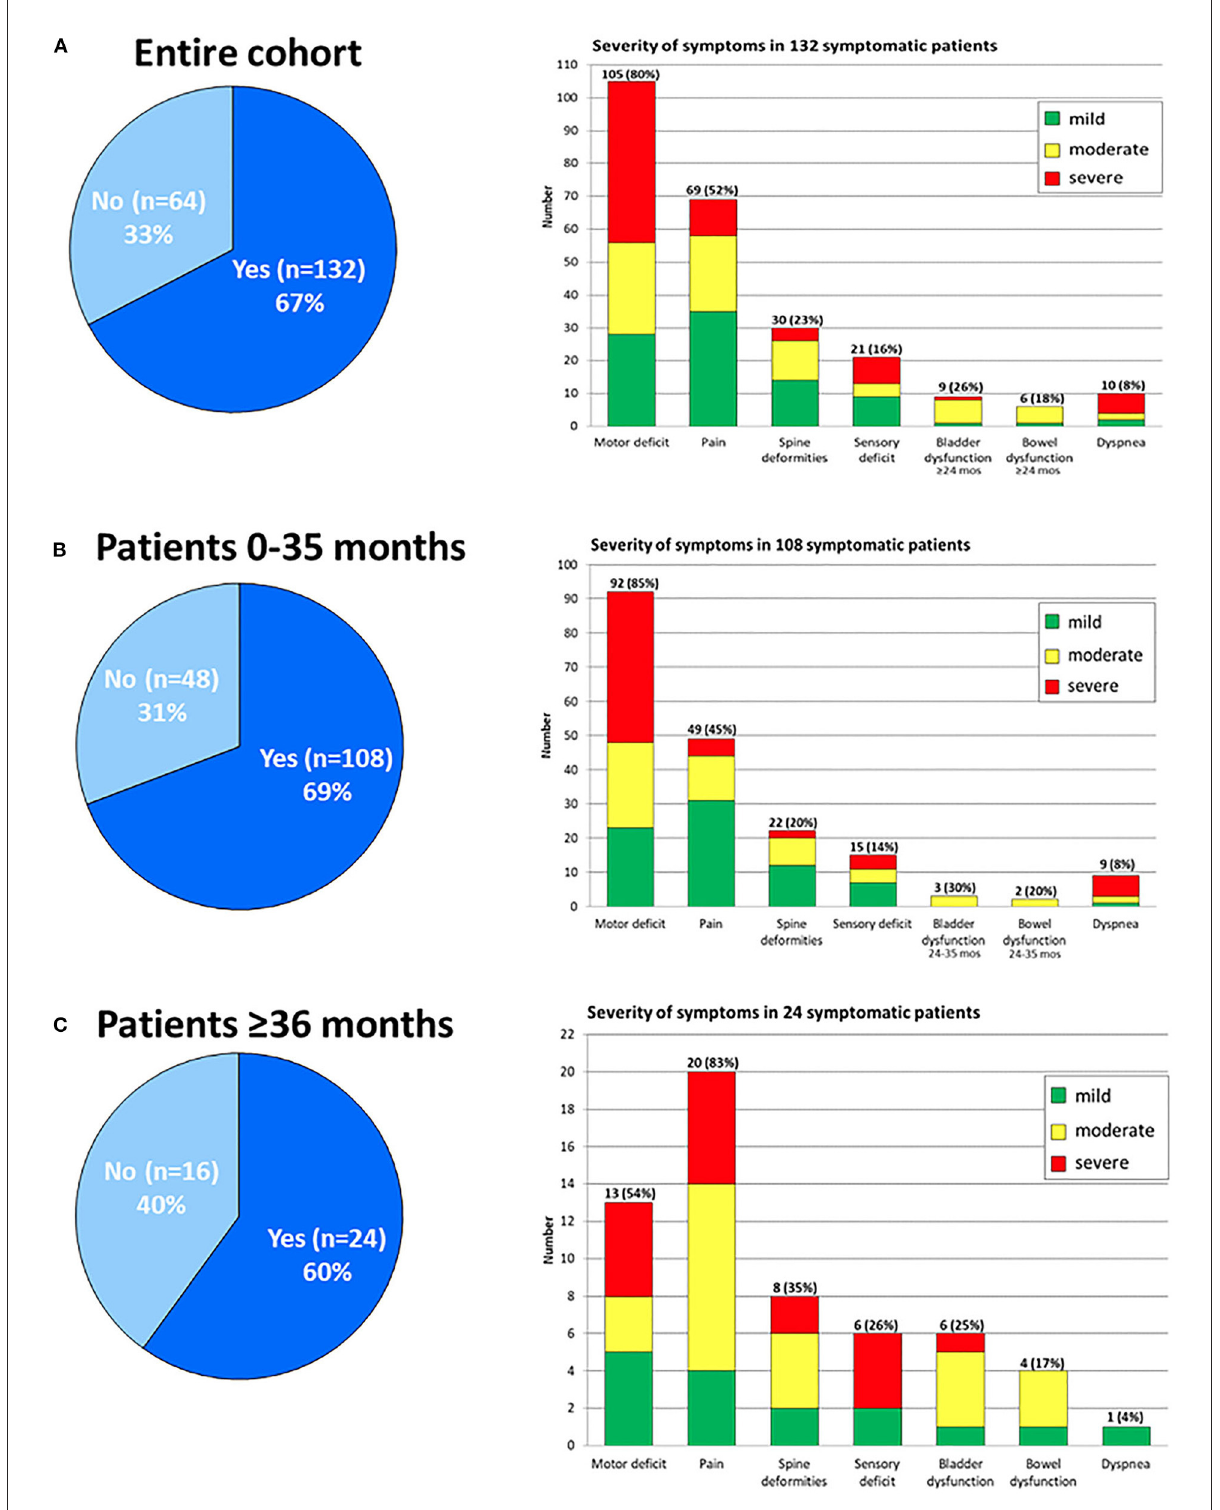
FIGURE1 Presence of SCI-related symptoms in the entire patient cohort [ (A) , left]. Frequency, types and severity scores of symptoms in symptomatic patients [ (A) , right]. Same for the 0–35 months old (B) and ≥ 36 months old patients (C)